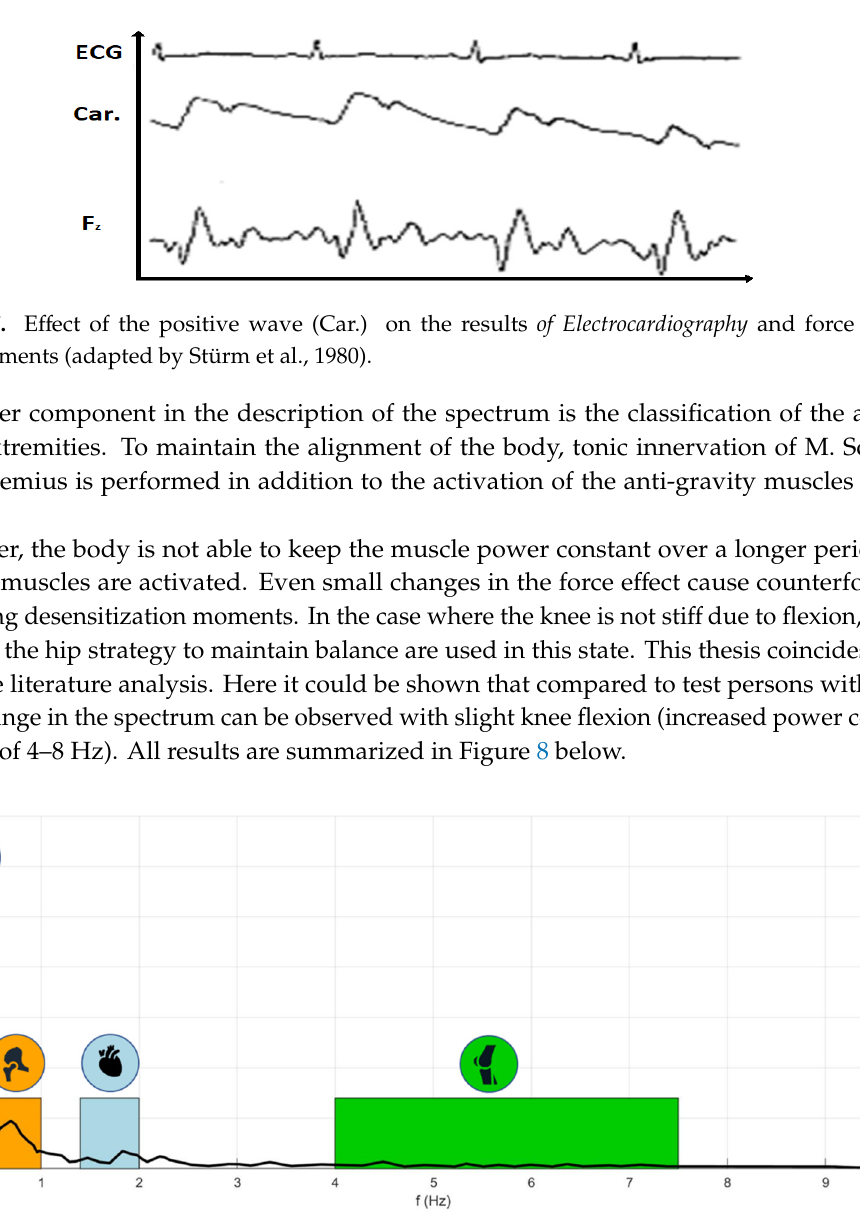
Figure 8. CoP spectrum with assignment of different functional sections. Red : respiration; yellow: pendulum movement around the hip; blue: cardioactivity; green: activities of the lower extremities. For the measurements with test persons, fixed position marks for the test persons’ feet were